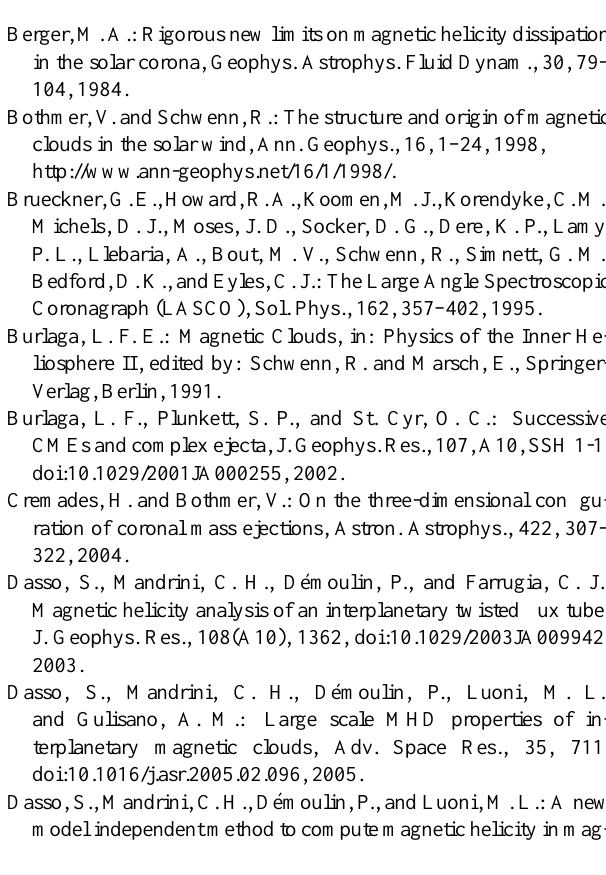
Fig. 15. The three components of the magnetic field at Ulysses for the event of January 2005. The fit of the Hidalgo et al. (2002b) model is overplotted in